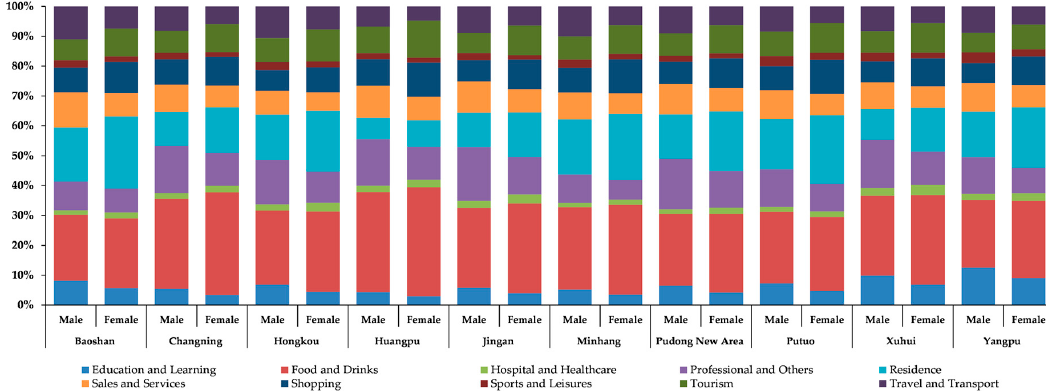
Figure 8. Check-in trend of activities during a week in Shanghai: (a) overall and for (b) men (c) and women.